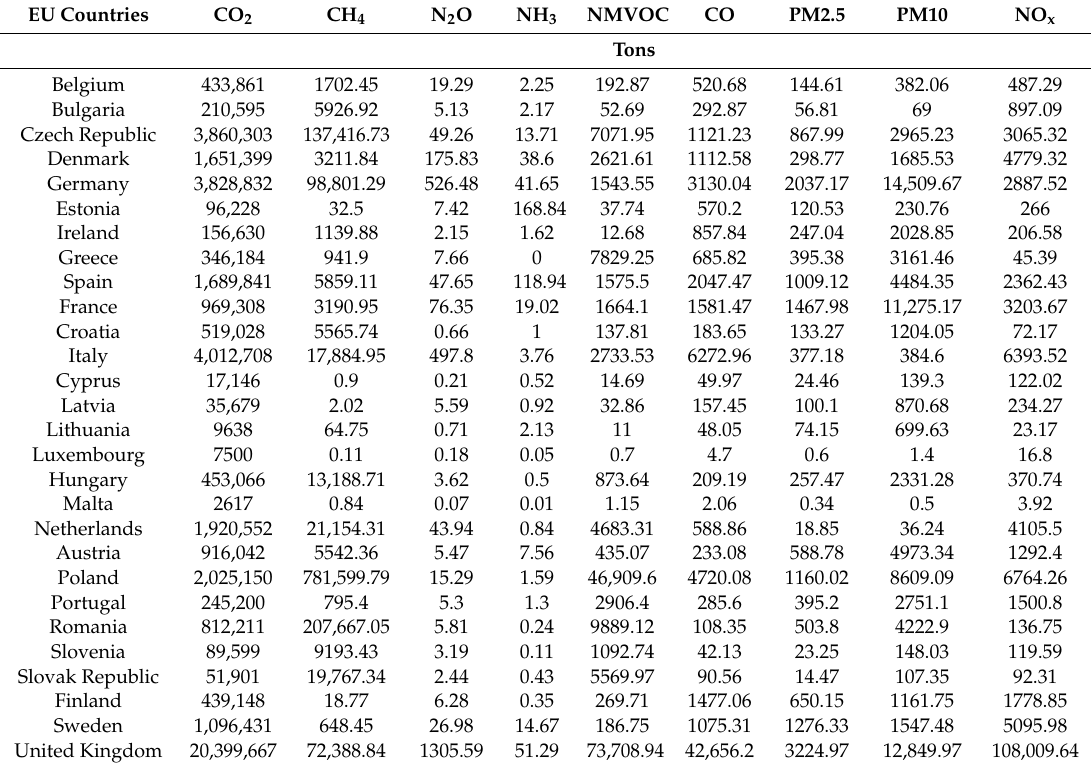
Table 1. Gas and air pollutant emissions into the atmosphere by European Union (EU) countries from the mining and quarrying sector in 2017 (own elaboration based on data from [45]). EU Countries